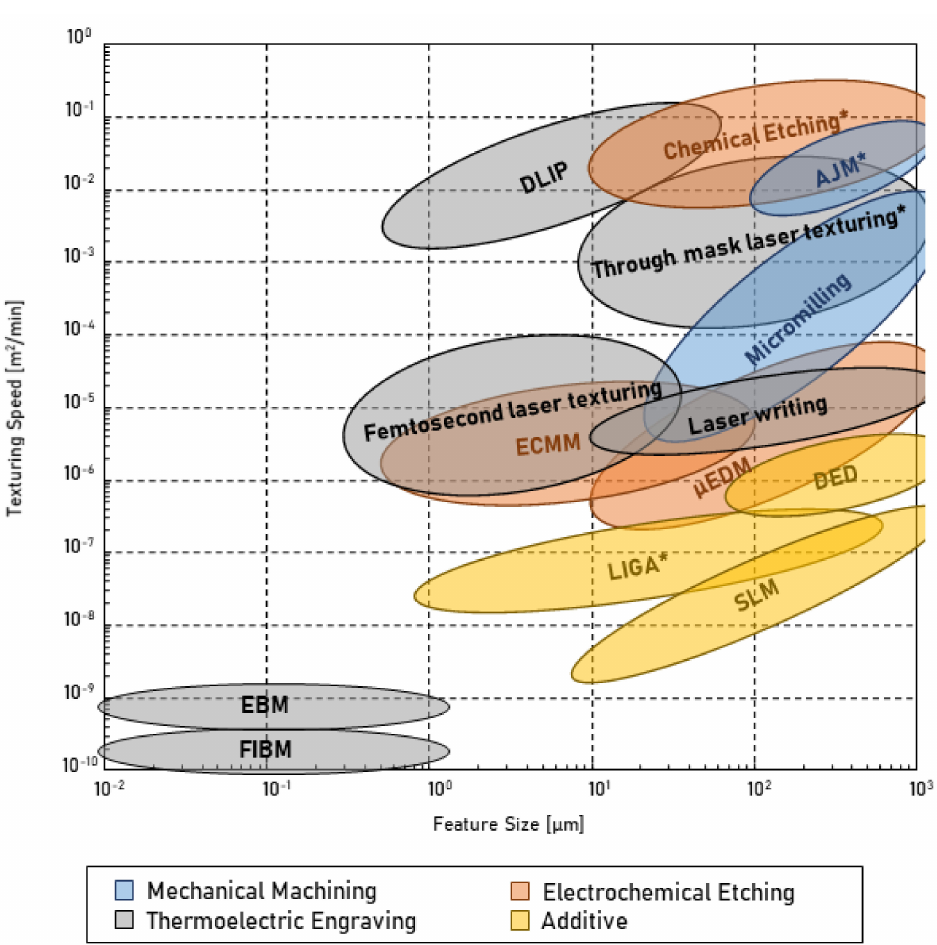
Figure 18. Feature size and texturing speed capabilities of surface texturing technologies. Multi-step technologies are indicated with a star